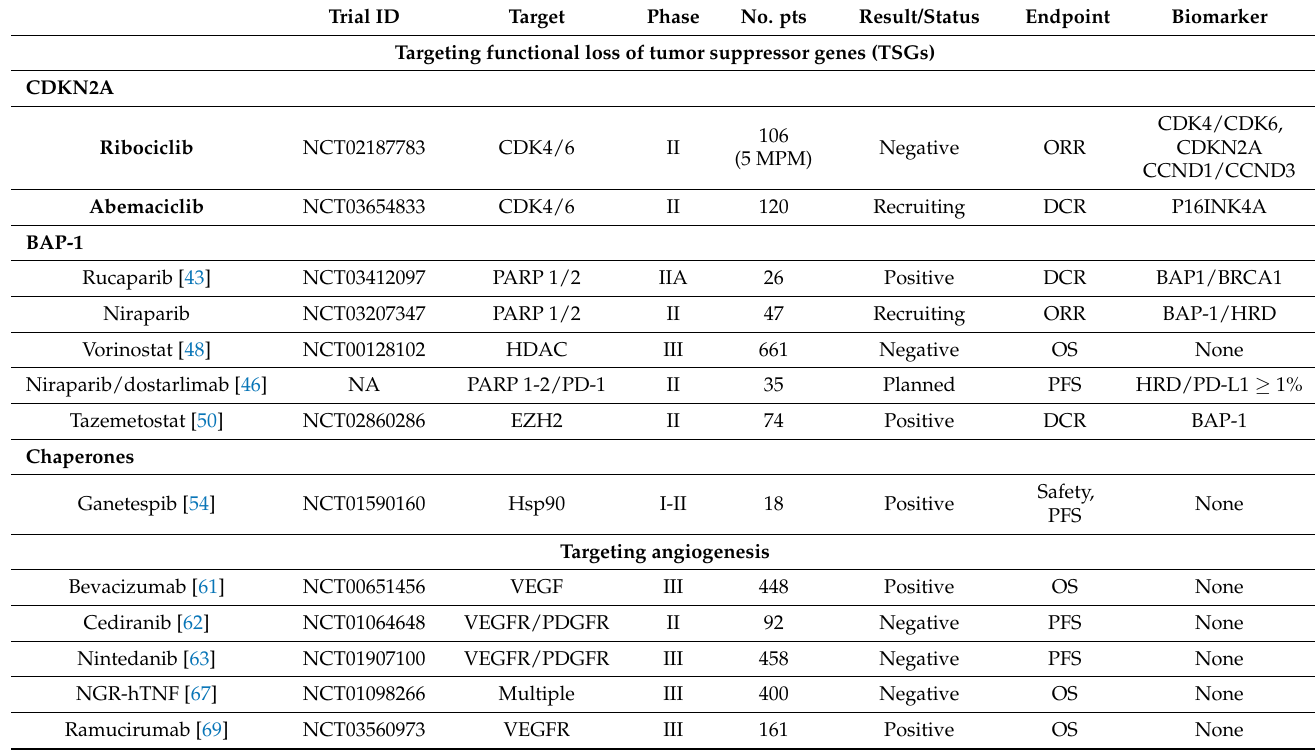
Trial ID Target Phase No. pts Result/Status Endpoint